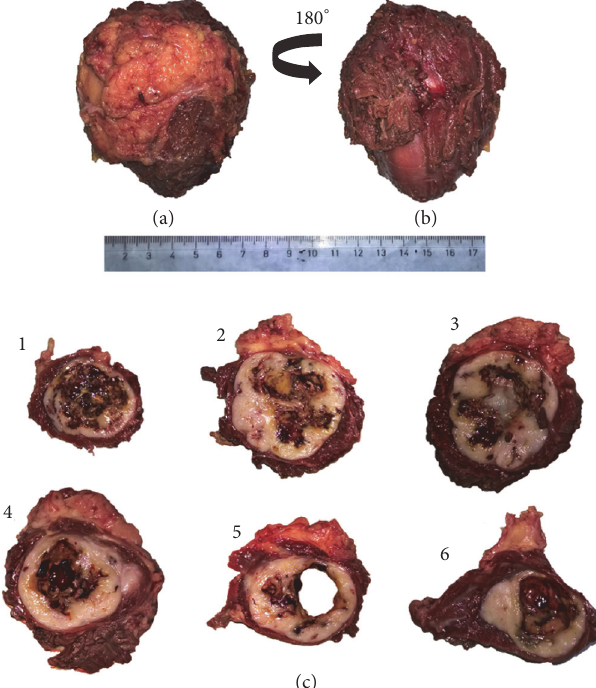
Figure 2: Gross appearance of the resected specimen. (a) Superficial view; (b) deep view; (c) sectioning of the mass, showing central necrosis and macrocystic change (1–6: proximal to